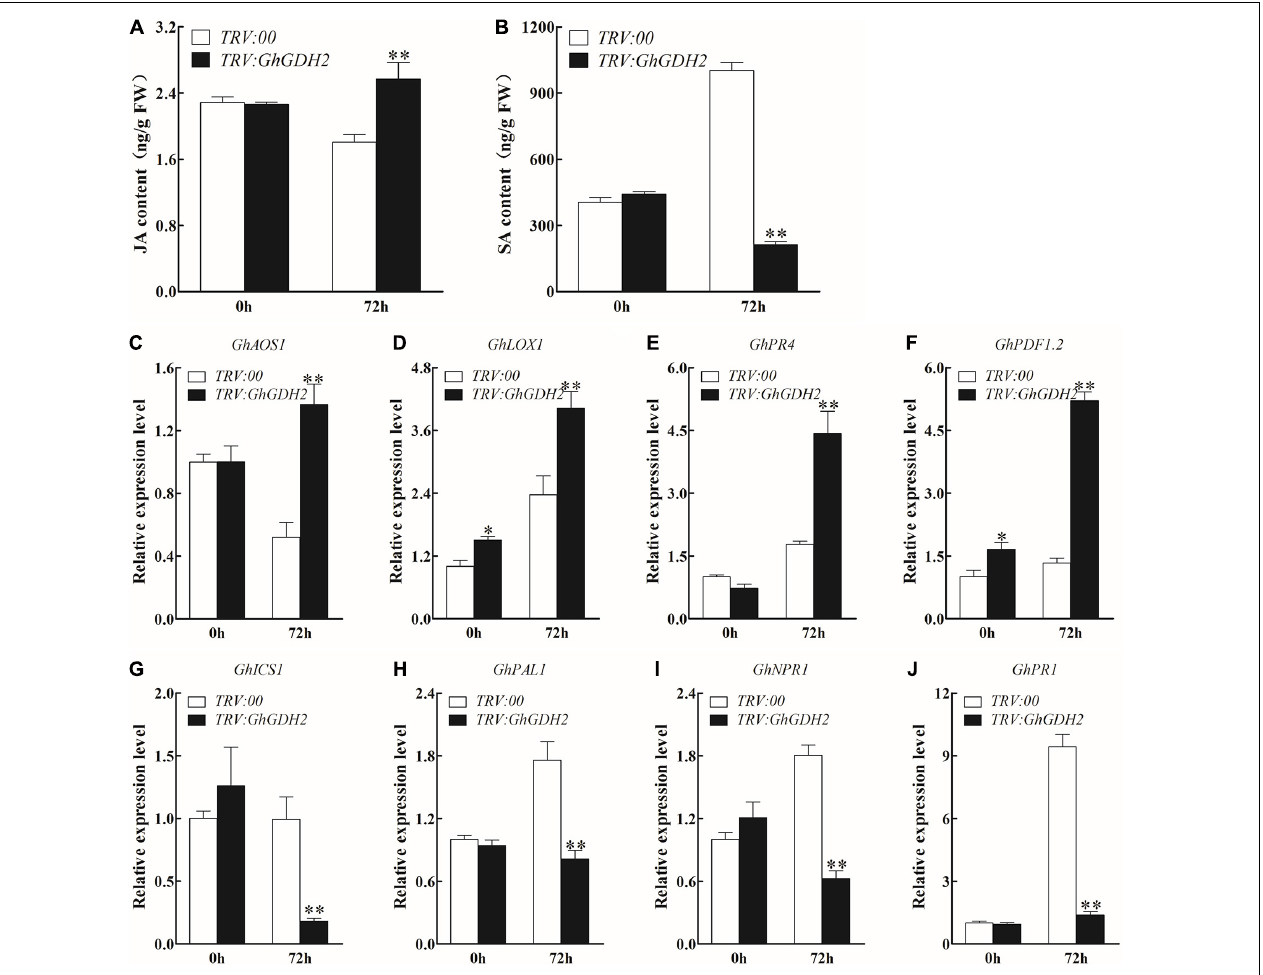
FIGURE 8 | The change of jasmonic acid (JA) and salicylic (SA) signaling pathway in GhGDH2 -silenced cotton plants. (A,B) Comparison of the (A) JA and (B) SA contents in TRV:00 and TRV:GhGDH2 plants at 72 h post-inoculation (hpi). (C–F) The relative expression levels of JA biosynthesis and response genes in TRV:00 and TRV:GhGDH2 plants at 72 hpi. (G–J) The relative expression level of SA biosynthesis and response genes in TRV: 00 and TRV:GhGDH2 plants at 72 hpi. Values represent mean ± SE of three independent biological replications (five individual plants per replicate). ∗ and ∗∗ represent significant differences from 0 h at P < 0.05 and P < 0.01, respectively, based on Student’s t